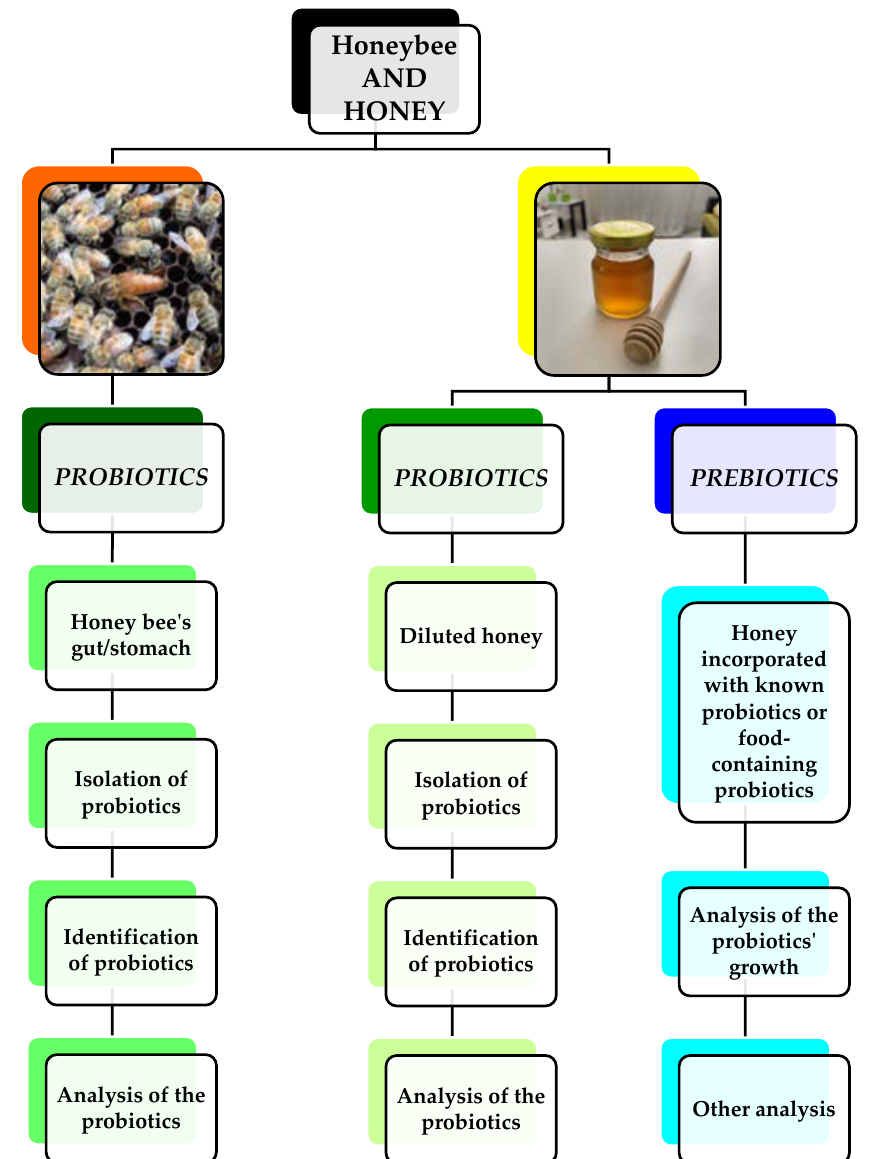
Figure 1. Flowchart of the honey bees and honey as a source of probiotics and prebiotics.